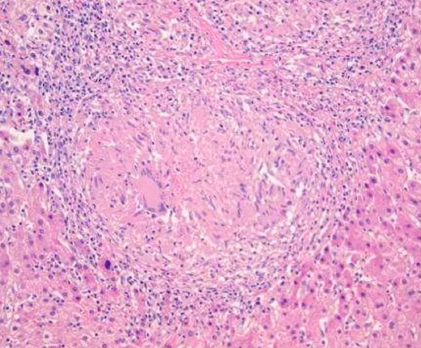
Figure 2: The biopsy demonstrates mildly distorted hepatic architecture due to marked inflammation and presence of granulomas. There is cholestasis. Many nonnecrotizing epithelioid granulomas, some confluent, are seen in the portal tracts, periportally and in the lobules. Portal tracts demonstrate mild acute and chronic inflammation (in association with granulomas), bile duct damage and mild proliferation of bile ductules accompanied by neutrophils. Ceroid-laden macrophages are seen in the lobules. There is periportal fibrous expansion and focal portal-portal bridging.